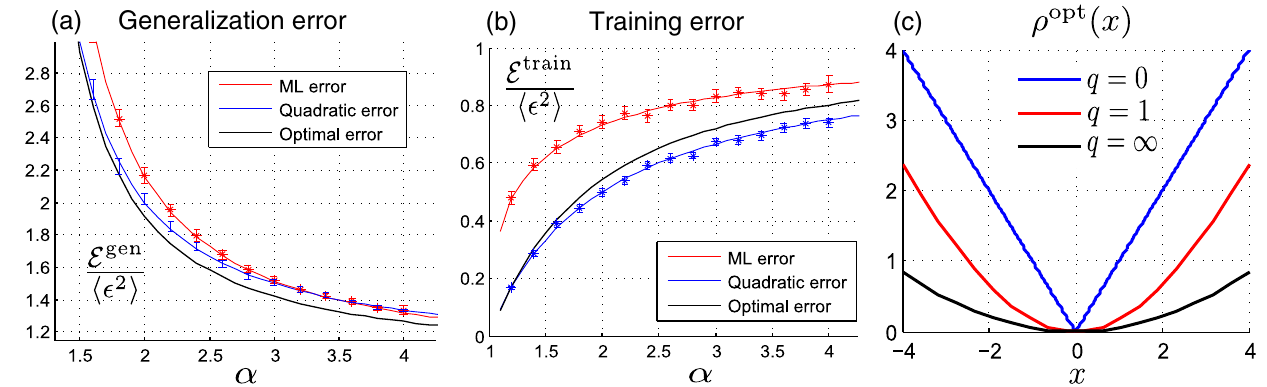
FIG. 4. Unregularized inference for Laplacian noise E ϵ ¼ j ϵ j . A comparison of the generalization error (a) and training error (b) of the optimal unregularized M-estimator (20) (black lines) with ML (red lines) and quadratic (blue lines) loss functions. Solid curves reflect theoretically derived predictions of performance. Error bars reflect performance obtained through numerical optimization of Eq. (1) using standard convex optimization solvers for finite-size problems ( N and P vary, with N ¼ α P and error bars reflects standard deviation of performance across 100 different realizations of the quenched disorder. (c) The shape of the optimal loss function in Eq. (20) for high-dimensional inference as a function of the error or smoothing parameter q . As α varies from high to low measurement densities, q varies from low to high values, and the optimal loss function varies from the ML loss to quadratic. Intermediate versions of the optimal loss behave like a smoothed version of the ML loss, with increased smoothing as measurement density decreases (or dimensionality